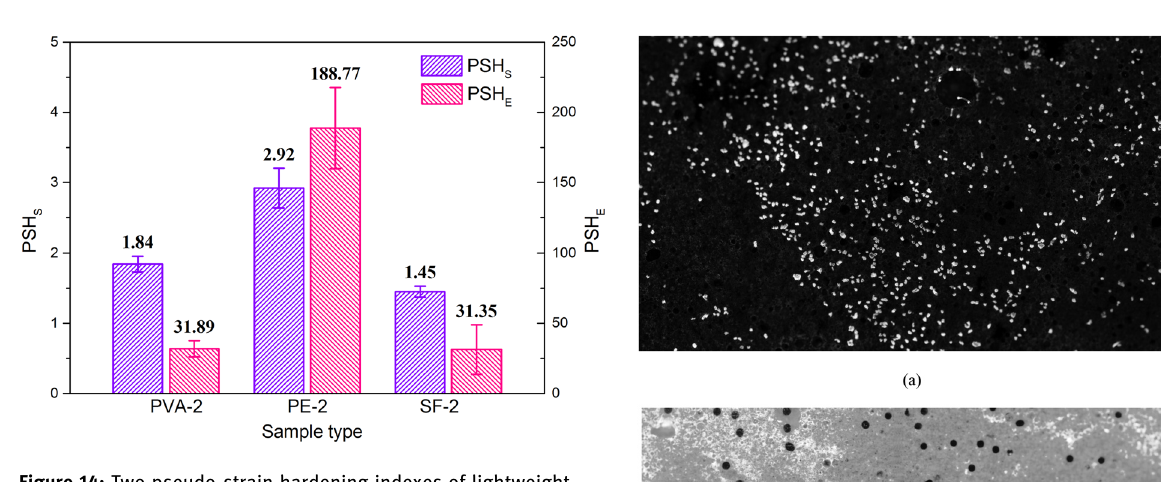
Figure 14: Two pseudo - strain hardening indexes of lightweight cement - based composites.